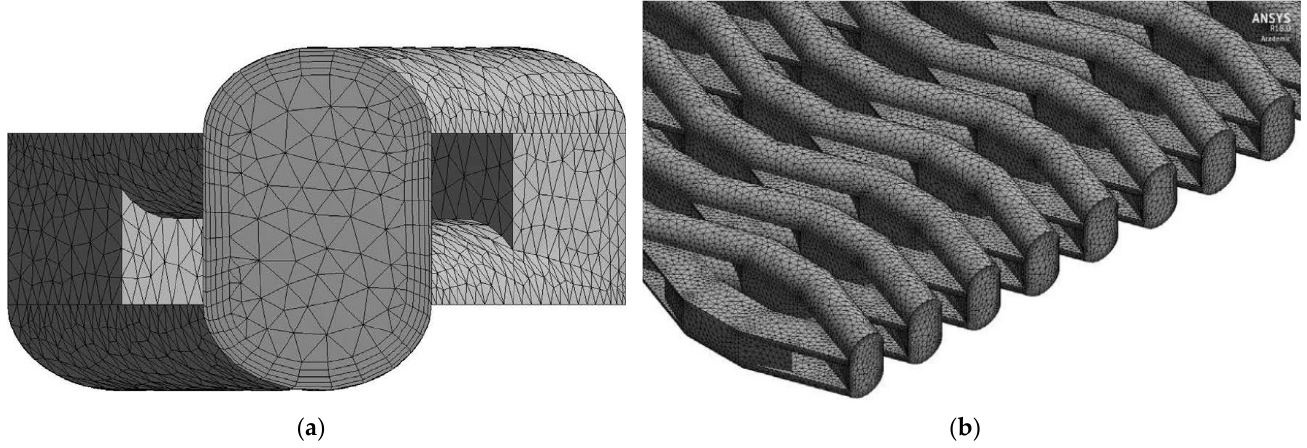
Figure 15. Computational mesh of CFD analysis performed by Lee and Lee: ( a ) Mesh of each channel; ( b ) Mesh of fluid part at main region of heat exchanger. Reprint with permission [82]; Copyright 2021, Elsevier.